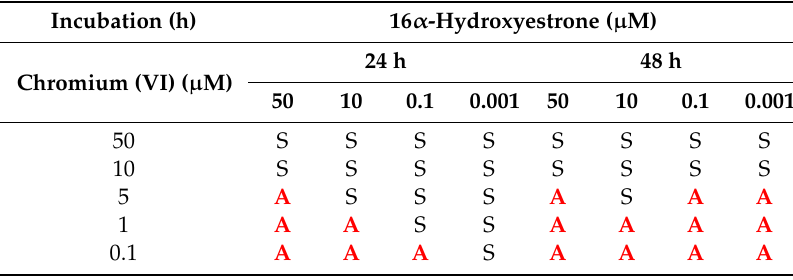
Table 3. Interpretation of the combined e ff ect of 16 α -hydroxyestrone and potassium chromate (VI) on SKOV-3 cells in the MTT assay after 24 h and 48 h of incubation, using the CompuSyn